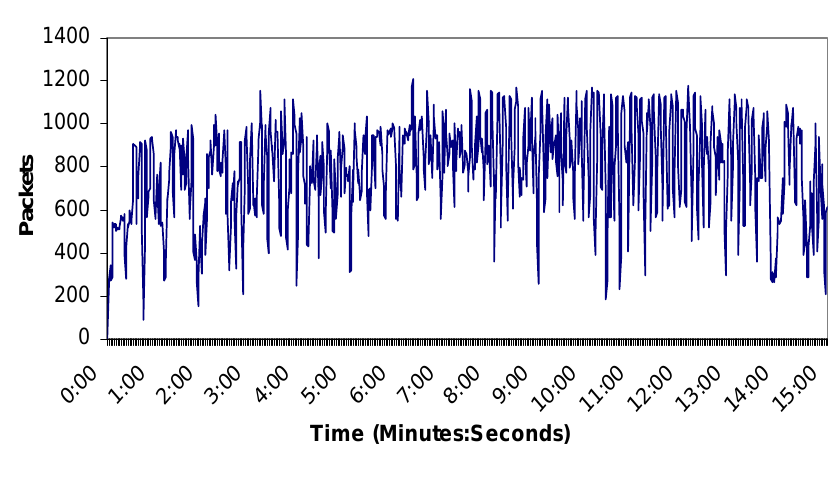
Figure 17. Number of packets per second.